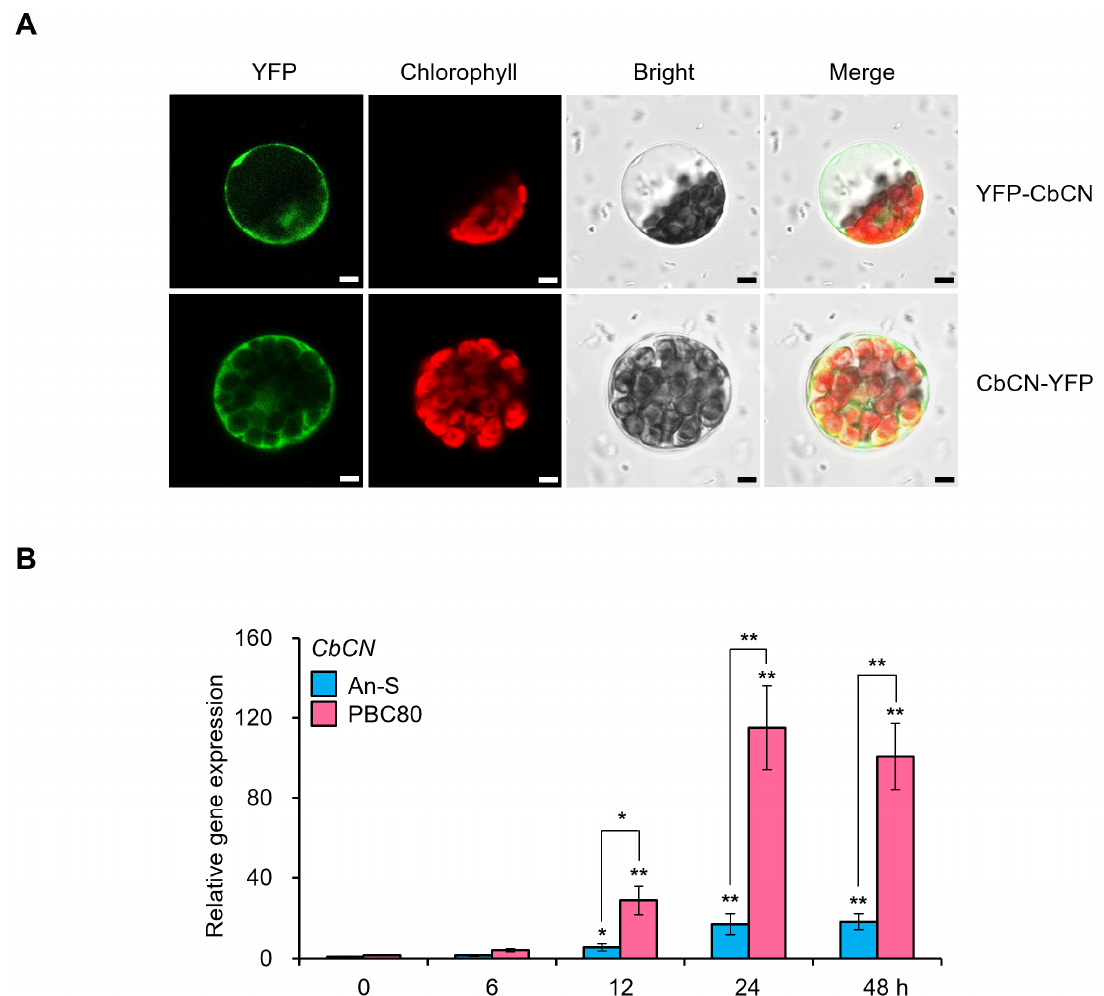
Figure 2. Analysis of CbCN subcellular localization and gene expression. ( A ) Subcellular localization of CbCN. N-terminal and C-terminal YFP-conjugated CbCN were transfected into chili pepper protoplasts and incubated for 12 h. Images were taken with a confocal microscope after the incubation. RFP marks the chlorophyll. Scale bar: 10 mm. ( B ) Expression analysis of CbCN after C. acutatum inoculation for the indicated times using RT-qPCR. Actin served as a control. Values represent means ± SDs. Asterisks indicate values significantly different from An-S at 0 h and between pepper varieties within same timepoint (* p < 0.05 and ** p < 0.01). All experiments were repeated at least three times and they generated similar results.